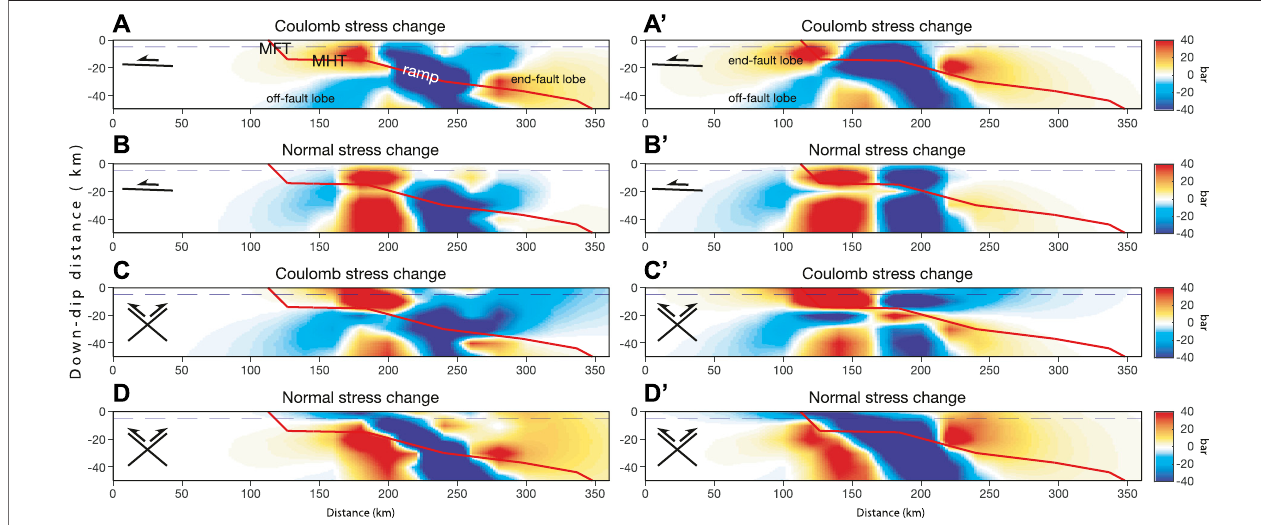
FIGURE11| Cross-sectionviewofthedistributionofstaticstresschangescausedbythe1714Bhutanearthquakealongapro fi leperpendiculartothestrikeofthe MFT. The left-hand panels show the Coulomb stress (A , C) normal stress (B , D) changes caused by a shock with hypocentre on the deep ramp of the MHT. The right- handpanelsshowtheCoulombstress (A 9 , C 9 ) normalstress (B 9 , D 9 ) changescausedbyashockwithhypocentreonthe fl aysegmentoftheMHT.Staticstresschanges are calculatedfor the subhorizontal planes withthe geometry 270/02/90( A , A 9 , B , B 9 ) and optimally oriented thrustfaults with the geometry 270/40/90( C , C 9 , D , D 9 ).